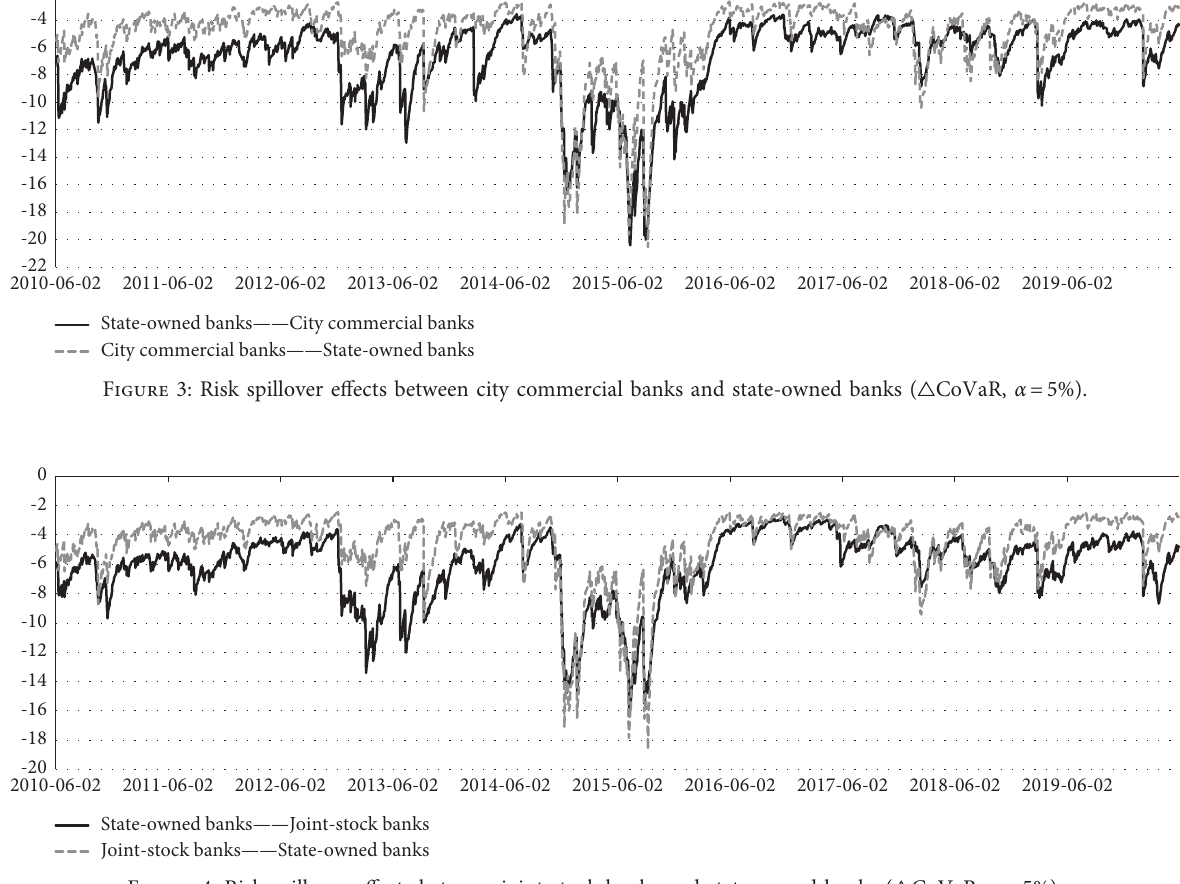
Figure 4: Risk spillover effects between joint-stock banks and state-owned banks ( △ CoVaR, α �